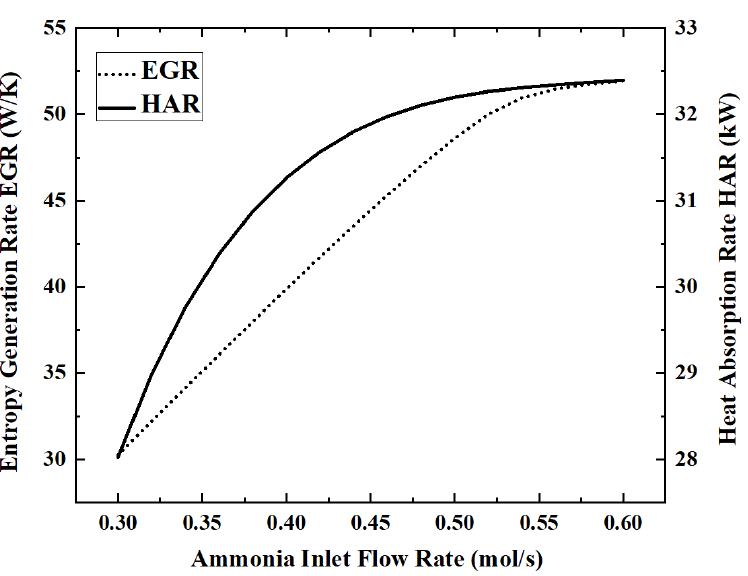
Figure 9. Effect of ammonia flow rate on EGR and HAR.